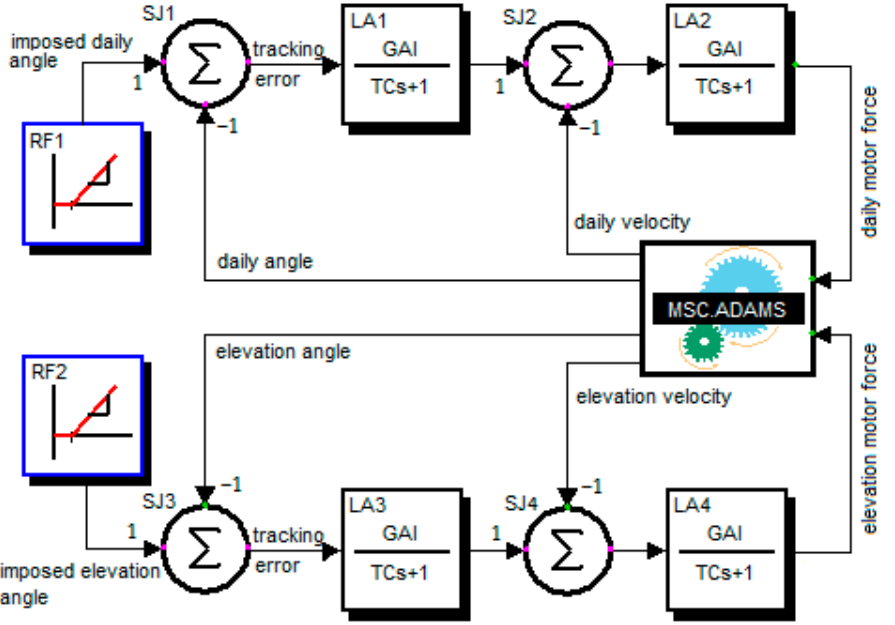
Figure 10. Control system block diagram for the bi-axial solar tracker (EASY5).